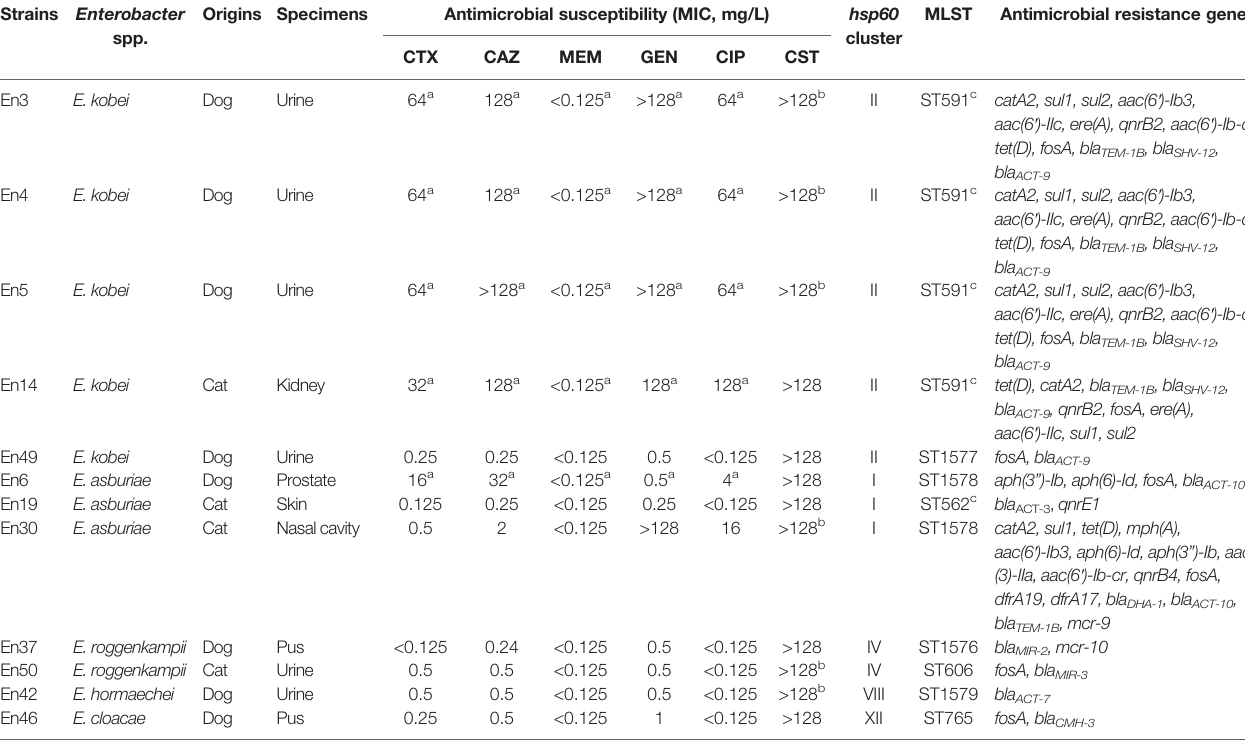
TABLE 1 | Characteristics of colistin-resistant Enterobacter cloacae complex isolates derived from companion animals. Strains Enterobacter